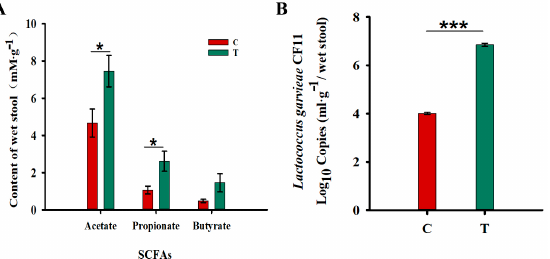
Figure 1. ( A ) Content of SCFAs in fecal feces of SD rats. ( B ) The population of CF11 Log10 16s rRNA gene copies. Rats in the experimental group (T) were given the mixed CF11 every day. The control group (C) rats were given the same volume of PBS (phosphate buffer saline) every day. Each group n = 4; * p value < 0.05; *** p value < 0.001.